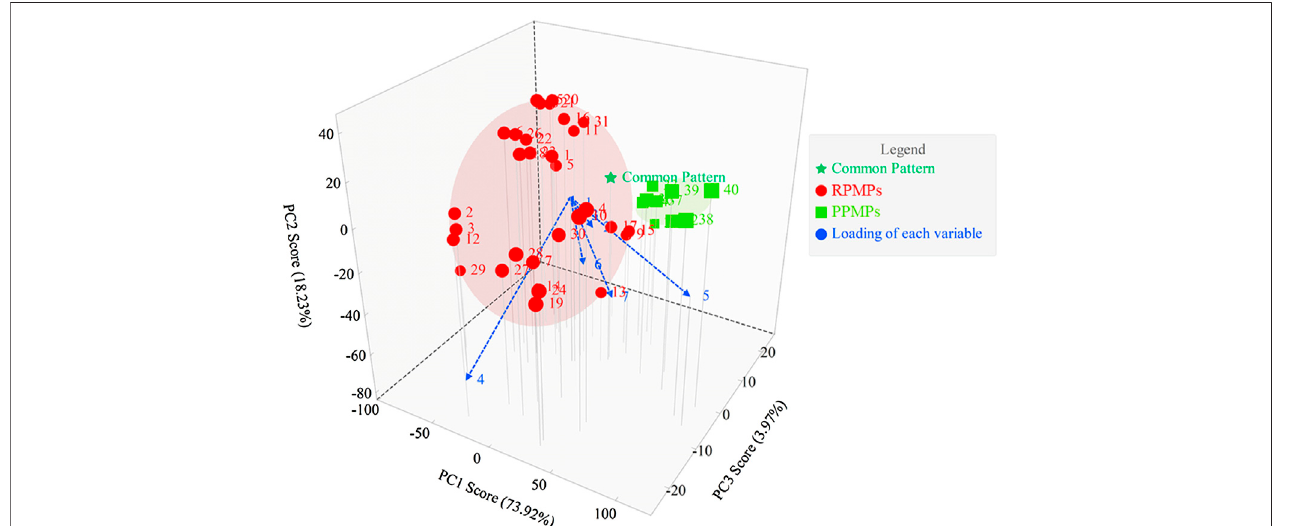
FIGURE 4 | The score plot and loading plot of PCA from PCD-UPLC fi ngerprints.